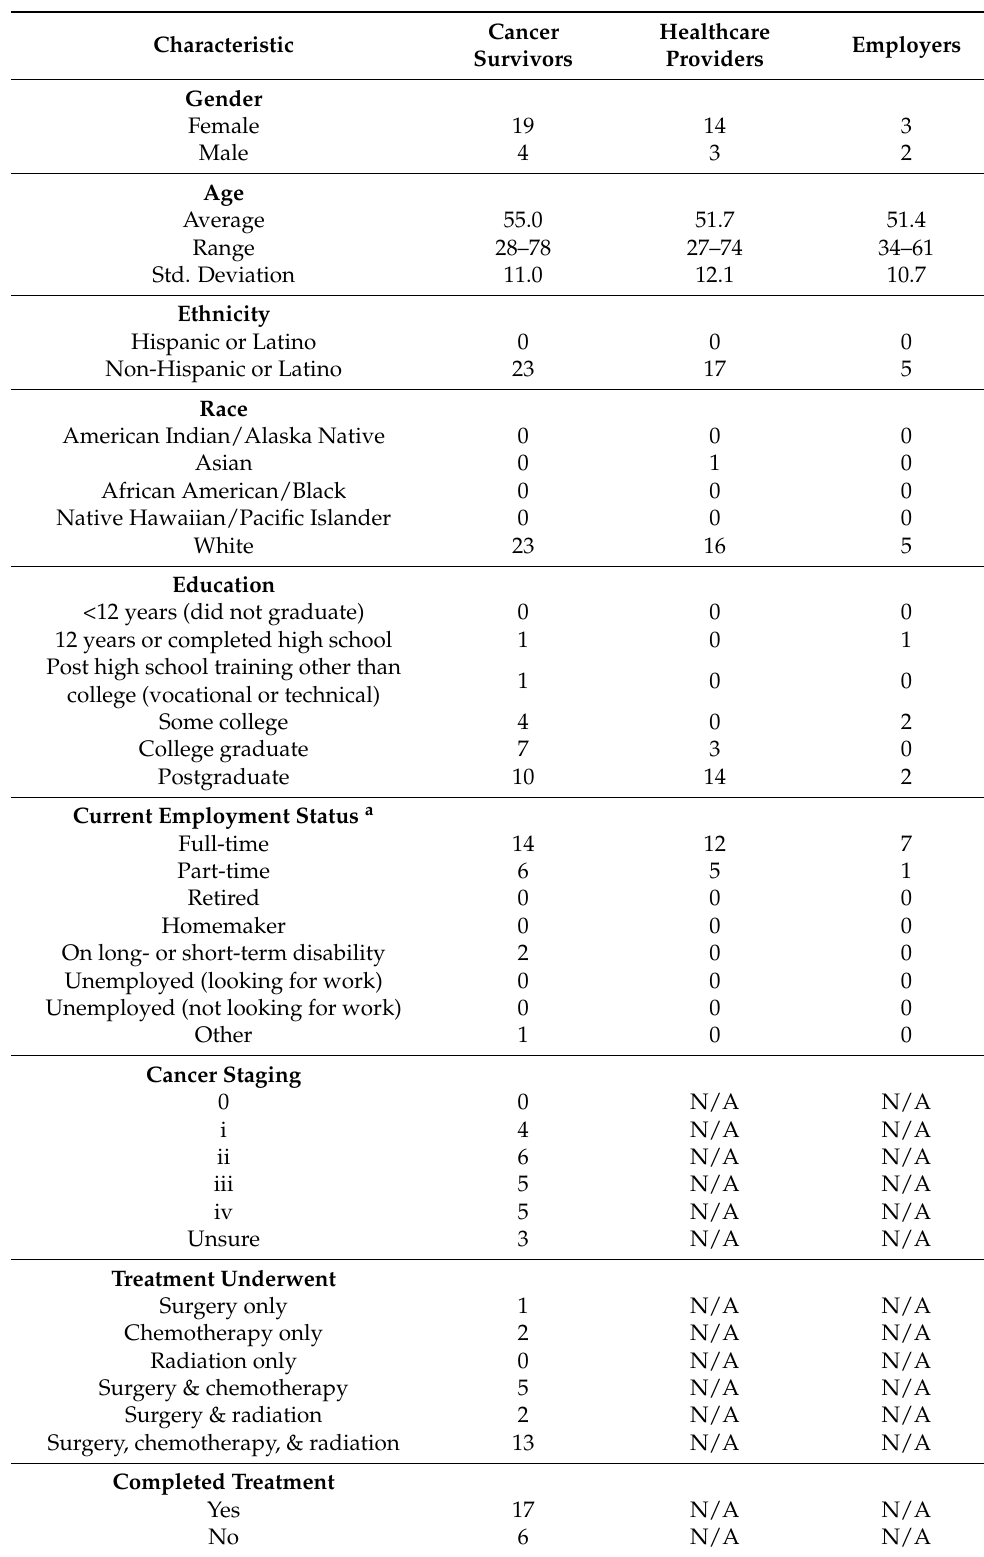
Table 1. Participant characteristics ( N =